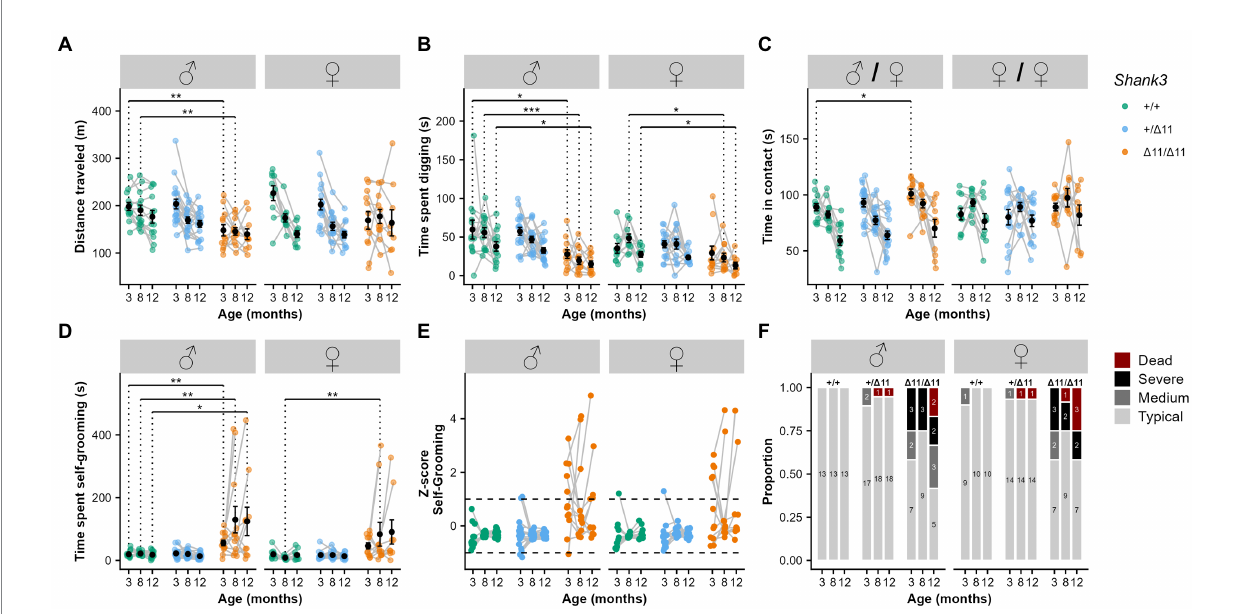
FIGURE 1 Hypoactivity, reduced exploration and increased stereotyped behaviors in Shank3 Δ 11/ Δ 11 mice at 3, 8, and 12 months of age. (A) Total distance traveled during 30-min free exploration of an open field in wild-type (green), heterozygous (blue) and Shank3 Δ 11/ Δ 11 (orange) for males (left panel) and females (right panel). (B) Total time spent digging in fresh bedding during 10 min observation in a new test cage, after 10 min habituation. (C) Total time spent in contact during male/female and female/female social interaction. (D) Total time spent self-grooming during 10 min observation in a new test cage, after 10 min habituation. (E) Z -score for the time spent self-grooming. (F) Proportion and number of individuals displaying different levels of severity in self-grooming. “Dead” corresponds to animals that had to be euthanized due to severe self-inflicted injuries. (A–D) Black points represent mean with standard error of the mean (s.e.m). Mann–Whitney U test with Bonferroni correction for multiple testing (two tests): * Corrected value of p < 0.05; ** corrected value of p <